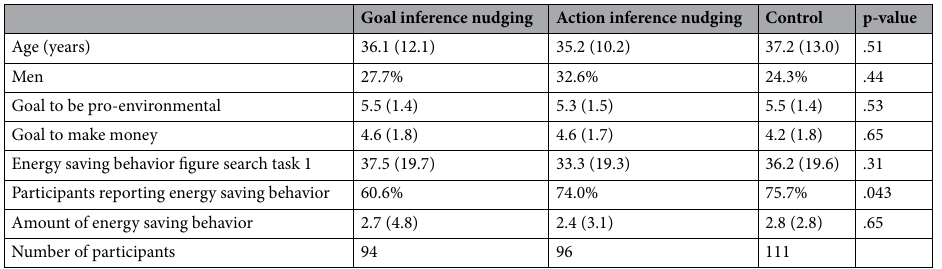
Table 1. Descriptives and randomization Check for Study 1. The table reports the average and standard deviations (in parentheses) of participant demographic variables and responses to questions about goals and prior energy saving behavior in each condition of Study 1, the p-value of the effect of condition in an ANOVA for each variable, and the number of participants in each condition. For the proportion variables (gender and proportion of participants reporting energy saving behavior), the p-value is for a Wald test. If a given p-value is greater than .05, it means the corresponding test does not allow us to reject the null hypothesis that all conditions have the same value for the corresponding